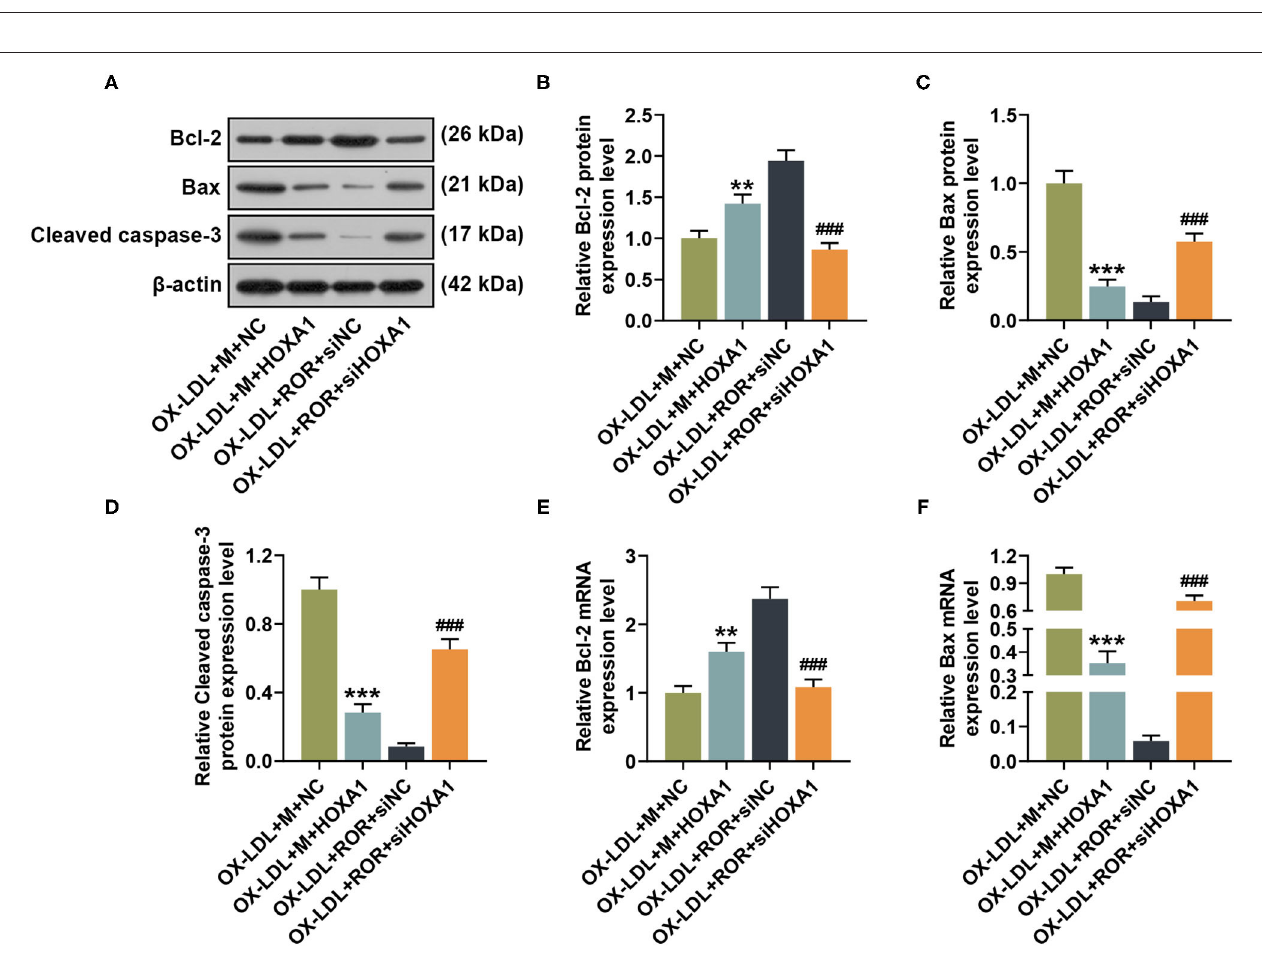
FIGURE 7 | The roles and functions of lncRNA ROR, let-7b-5p, and HOXA1 on apoptosis-related protein expressions. (A–D) The relative protein/ β -actin expression of Bcl-2 (B) , Bax (C) , and cleaved caspase-3 (D) was measured by Western blot. β -Actin was used as an internal control. (E,F) The relative mRNA expressions of Bcl-2 (E) and Bax (F) were measured by qRT-PCR. β -Actin was used as an internal control. All experiments have been performed independently in triplicate, and data were expressed as mean ± standard deviation. Statistical significance was assessed by one-way ANOVA, followed by Tukey’s post-hoc test. ** P < 0.01, *** P < 0.001 vs